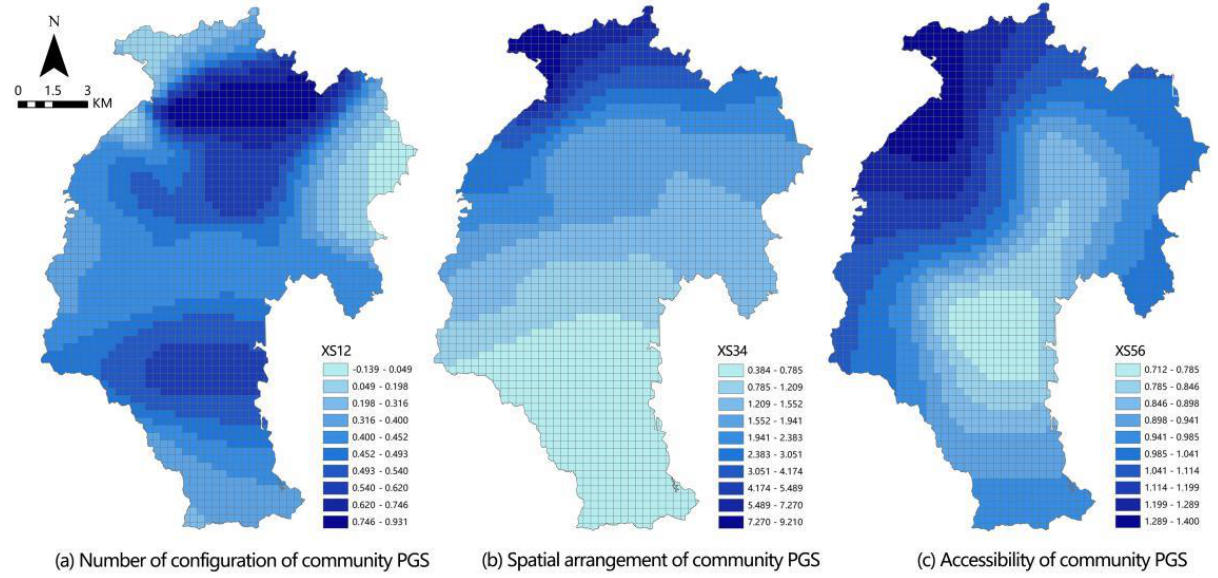
Figure 10. Spatial patterns of correlation coefficients between subsystems of community PGS and CCD.